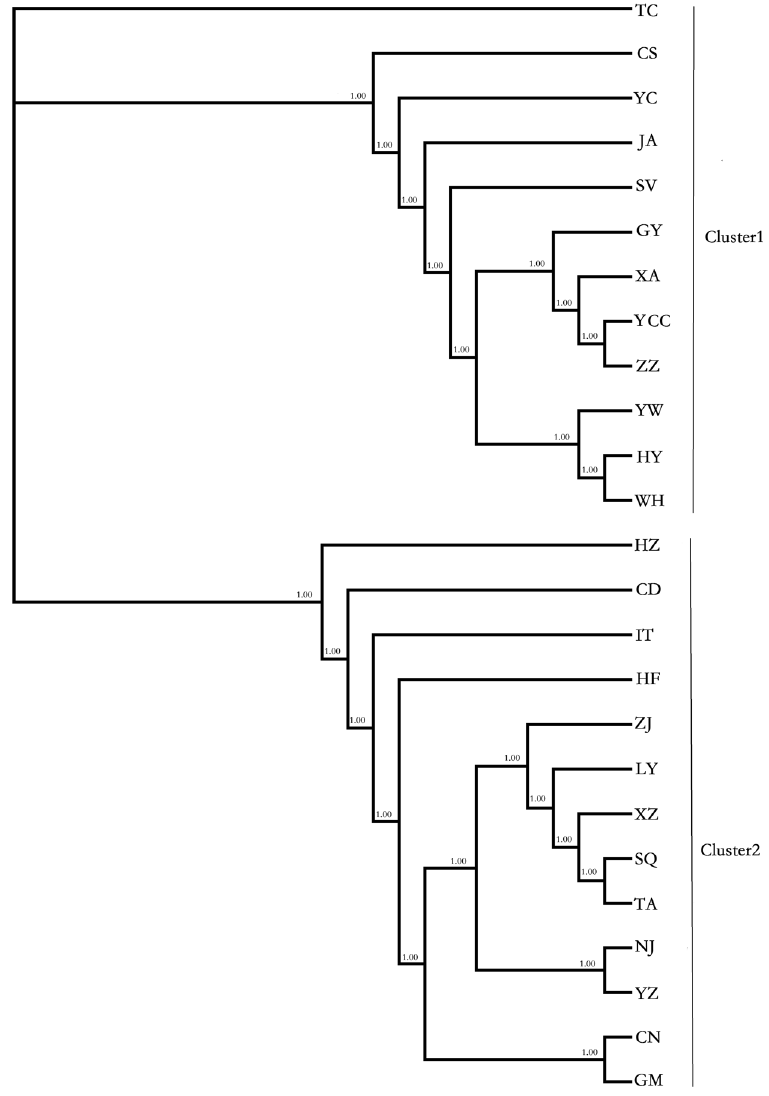
test to analyze whether the heterozygosity excess was significant. Two populations (CS and TA) and one popu- lation (XZ) had a statistically significant excess of heterozygotes when analyzed using the infinite allele model (IAM) and two-phased model of mutation (TPM), respectively (Table 7). However, heterozygosity excess was observed in 12 populations (HF, GY, WH, ZZ, CS, LY, NJ, SQ, XZ, YZ, YC and JA) using the step-wise mutation model (SMM, Table 7), suggesting that most C. ciliata populations in this study underwent a genetic bottleneck. Discussion Genetic diversity and population